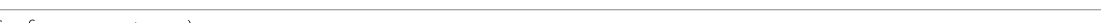
figure on next Fig. 7 Gamma Scintigraphy Imaging of radio-labelled microspheres in rabbits was done using two groups each consisting three animals. The SPECT CT imaging clearly depicted the retention of the formulation in the stomach and upper part of intestine thereby releasing the drug materials from there. A The scintigram represents the initial position of the radiolabelled formulation at time 0 h. From the image, the location of the dosage form can be clearly seen and almost negligible amount of drug is released at the given time. B The scintigram obtained after time 1 h clearly represents the location of the dosage form with the subsequent release of the drug from that specific area as indicated by the dark colour dots. C At time interval of 4 h, the scintigram obtained shows the presence of the dosage form in the same location within the GI tract with further drug release from there this justifies the mucoadhesive nature of the prepared microsphere formulation. D The scintigram obtained at time interval of 6 h gives the further indication of the location of the formulation which supports the design concept of this current study. It can be clearly seen that the drug is still adhered to the mucosal lining in the upper part of intestine with the active medicament slowly releasing from